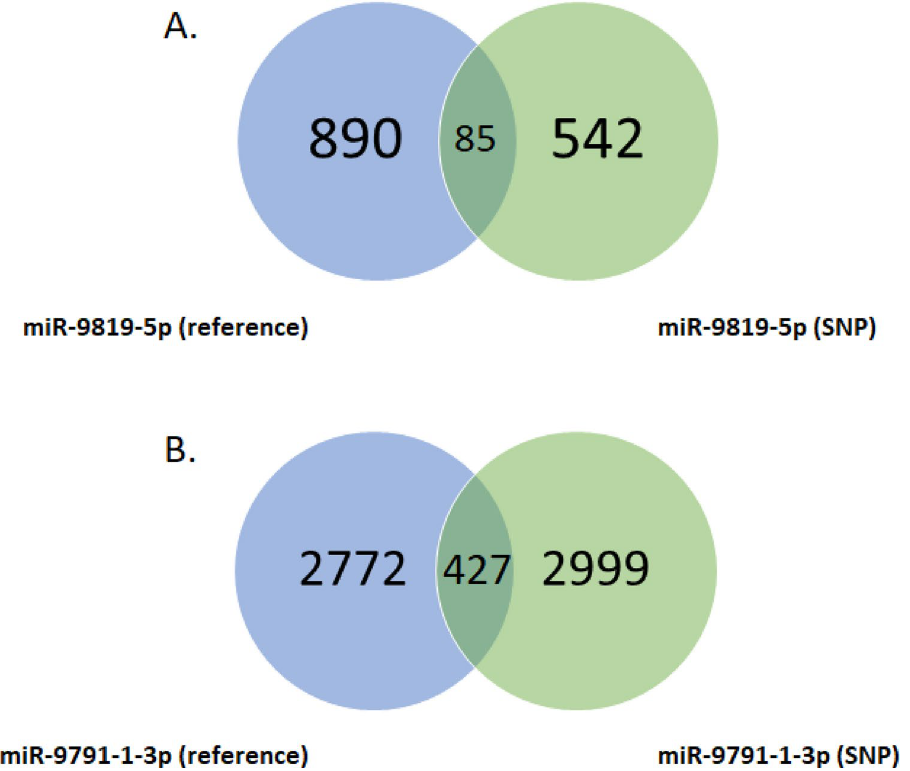
Figure 7. Venn diagram of target genes predicted for wild type and SNP-altered miRNA seeds: ( A ) data on the number of predicted target genes of miR-9819-5p for the reference seed (the blue circle), and the SNP-altered seed (the green circle); ( B ) data on the number of predicted target genes of miR-9791-1-3p for the reference seed (the blue circle), and the SNP-altered seed (the green